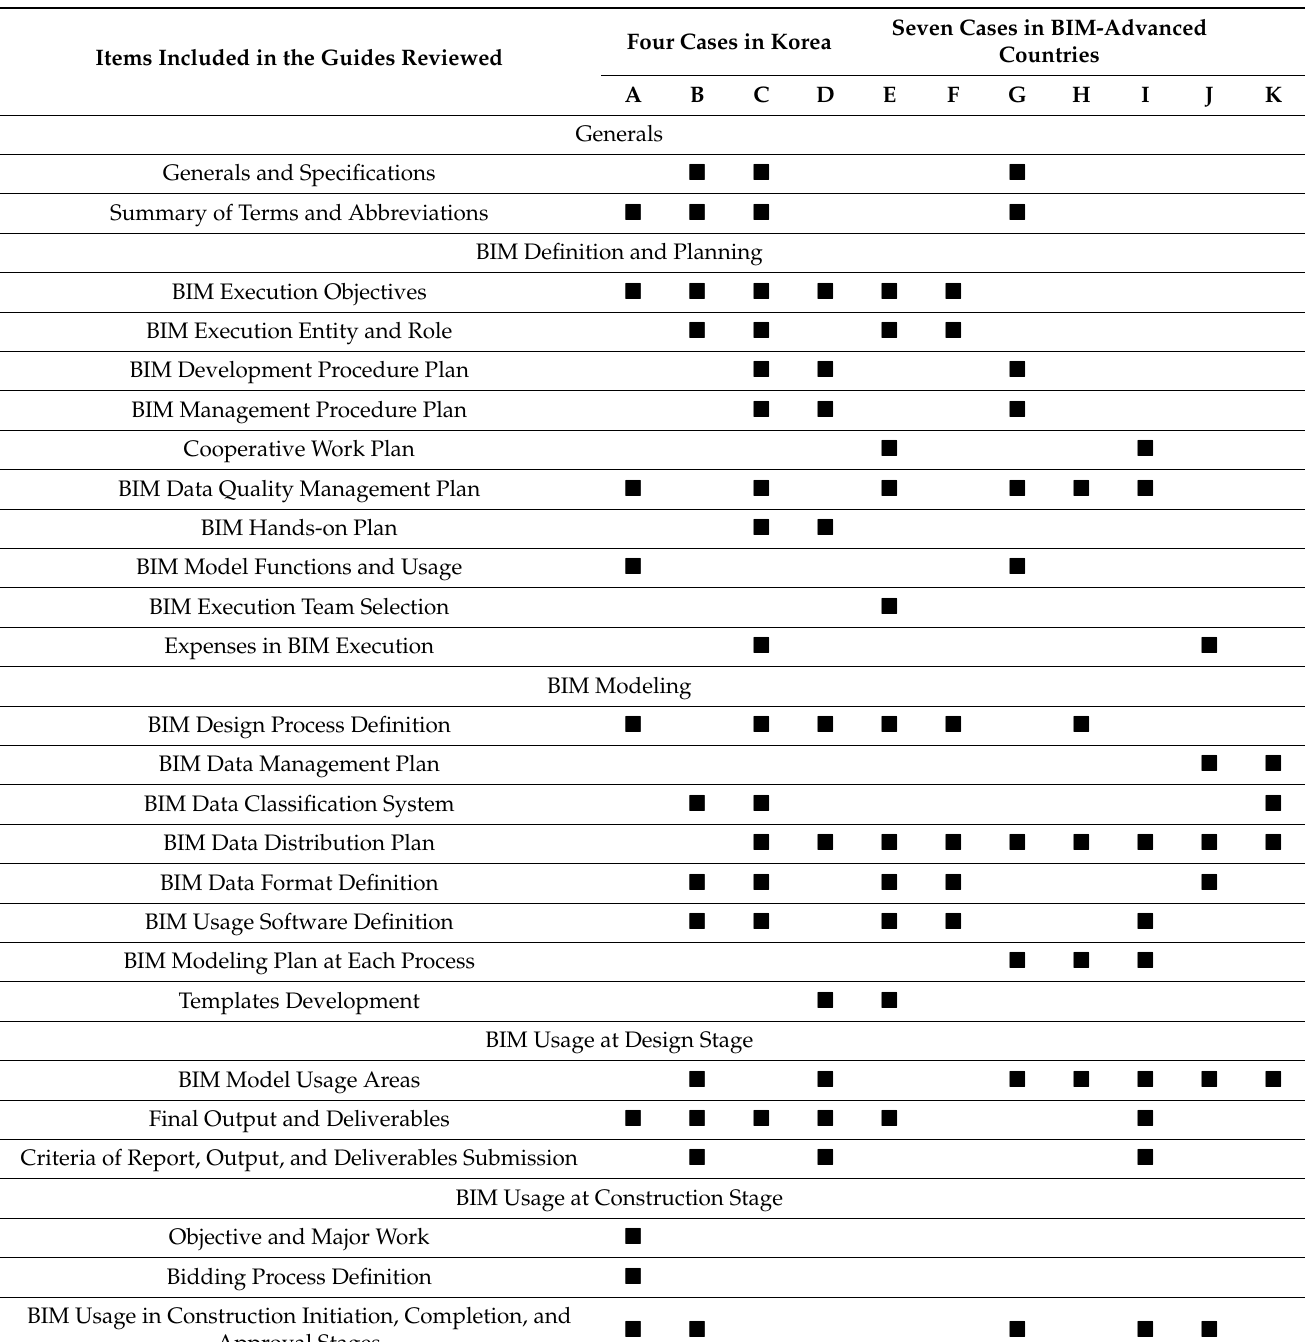
Table 4. Review results of the BIM